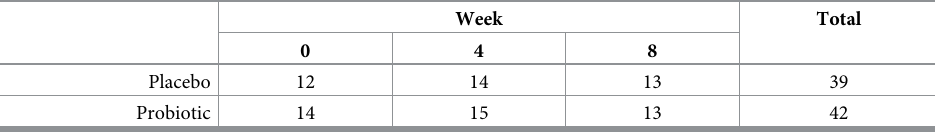
Table 1. Quantity of samples collected during the PICO study.